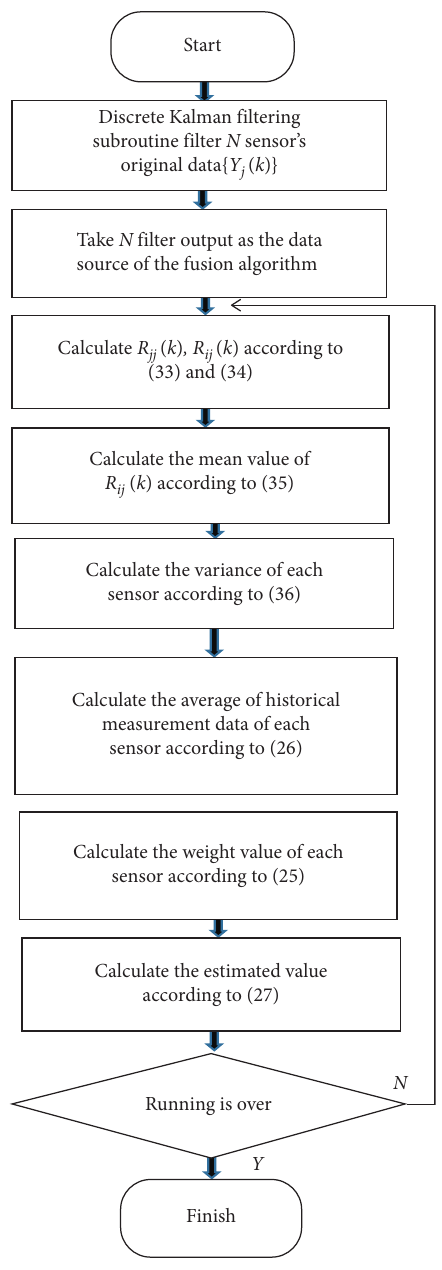
Figure 7: Flowchart of the improved autoadaptive weight fusion